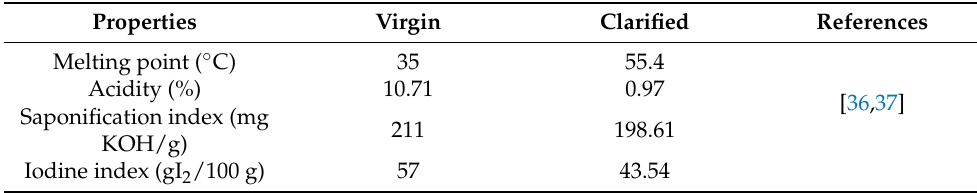
Table 6. Properties of virgin and clarified bacuri seed